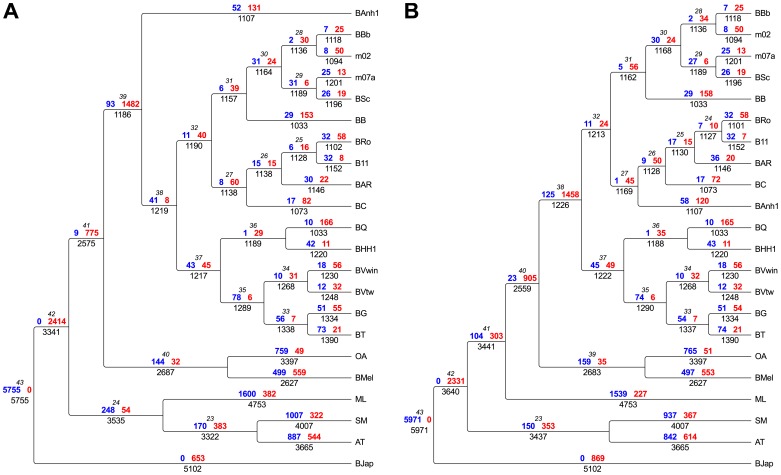
Flux of protein families in Bartonella and related outgroup species.The flux of protein families has been mapped onto the two most probable phylogenies, “BAnh1 early” shown in Figure 1B) (A) and “Radiation” shown in Figure 1C (B). Genesis (blue) and loss (red) of protein families are depicted above each branch, respectively. Total number of gene families is indicated below the branch. The node number is shown in italics. Abbreviations of Bartonella species are as in Table 1. Abbreviations of outgroup species: AT, Agrobacterium tumefaciens; SM, Sinorhizobium meliloti; ML, Mesorhizobium loti; BMel, Brucella melitensis; OA, Ochrobactrum anthropi; BJap, Bradyrhizobium japonicum.